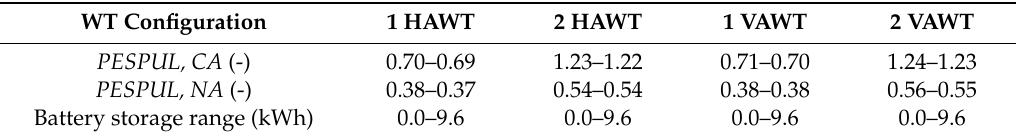
Table 7. Primary energy saving per unit load ( PESPUL) as a function of WT configuration and battery storage size. CA—Cagliari; NA—Naples.